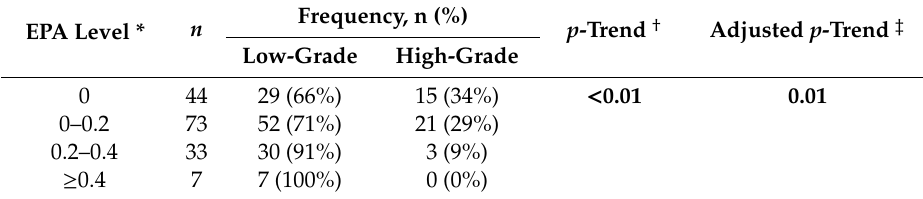
Table 4. Trend analysis of EPA level in prostate